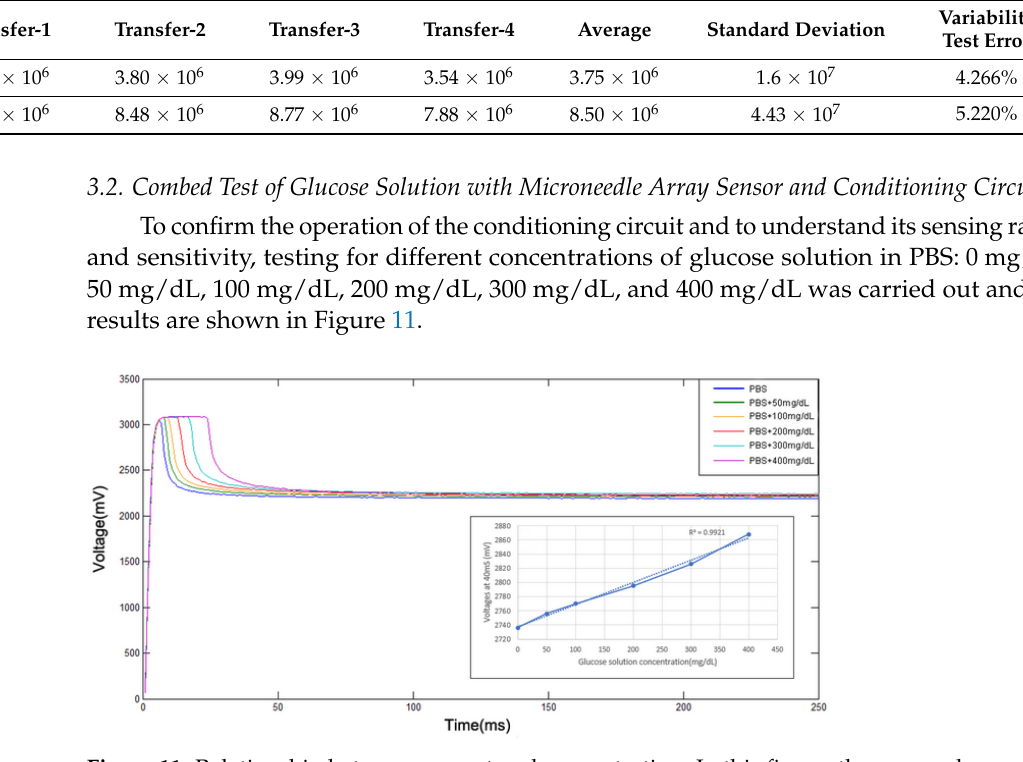
Table 3. Micro-transfer variability test error.